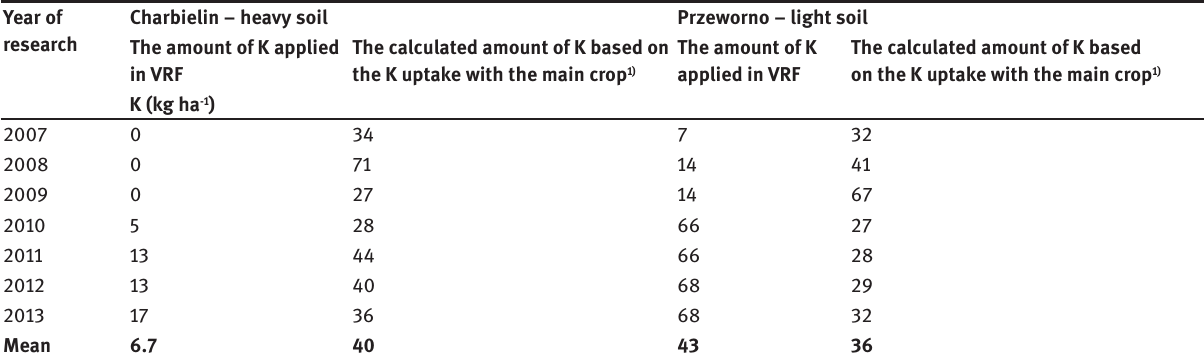
Table 4: Comparison of the potassium applied in VRF and the theoretical amount required for balancing of the K uptake with the main crop. Year of